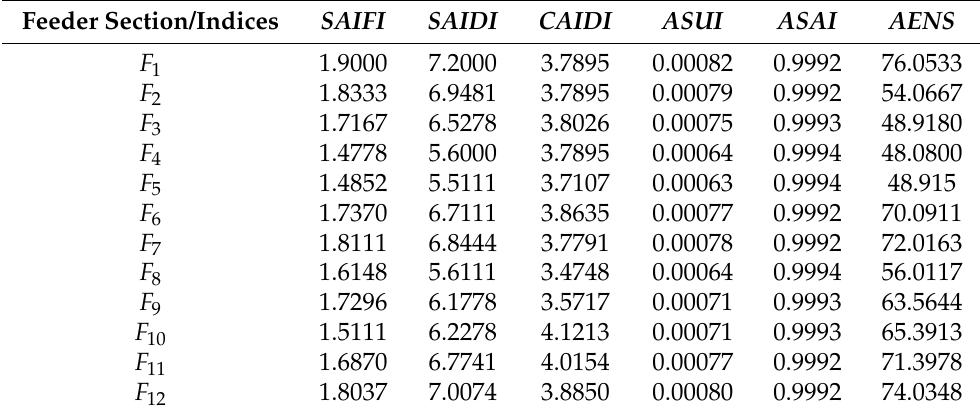
Table 2. Reliability indices of the 13-bus system with a recloser placement in different feeder sections. Feeder